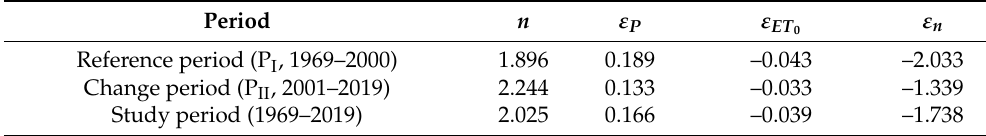
Table 2. The elasticity of runoff regarding each factor in different periods.